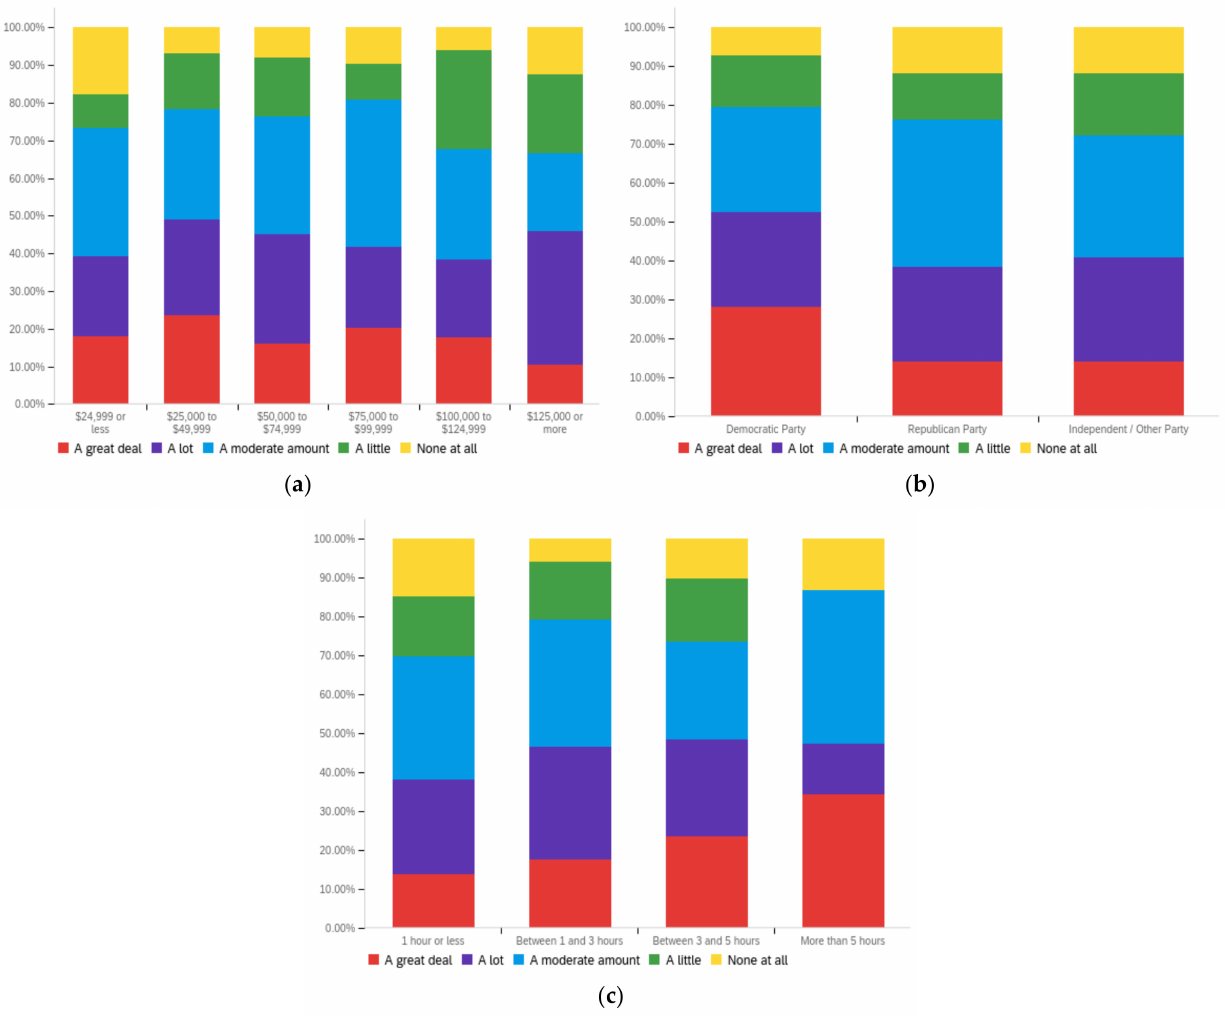
Figure A14. Article sponsor—others’ perception impact by: ( a ) income level (top left), ( b ) political affiliation (top right) and ( c ) online usage